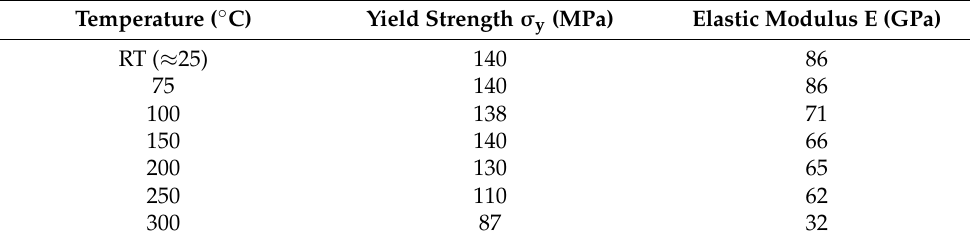
Table 1. Yield strength and elastic modulus at different temperatures.